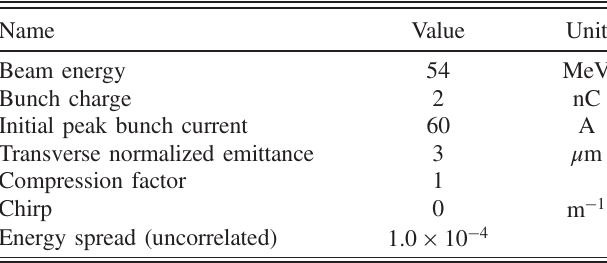
TABLE I. Initial beam parameters for CCR used in the simulation.